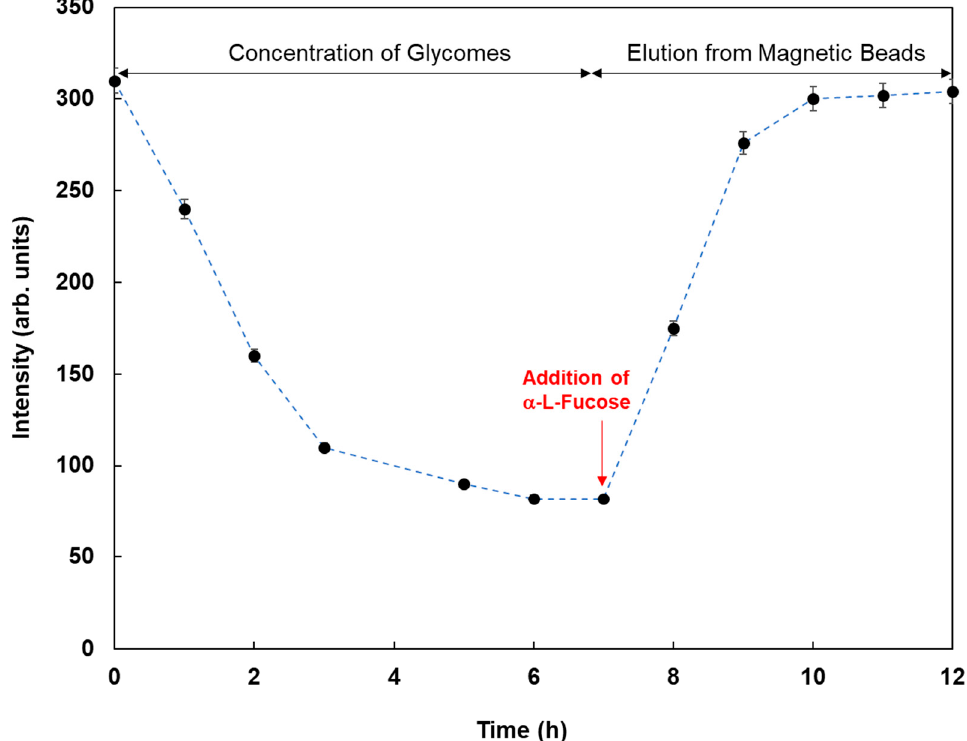
Figure 8. Fluorescence intensities of FMB-AAL with time by the reaction with cell lysates from MCF-7 before and after the addition of α -L-Fucose as the inhibitor sugar. [FMB-Con A] = 10 µ g/mL; [ α -L-Fucose] = 20.0 mM; Fluorescence measured at 575 nm; Excitation wavelength, 550 nm.